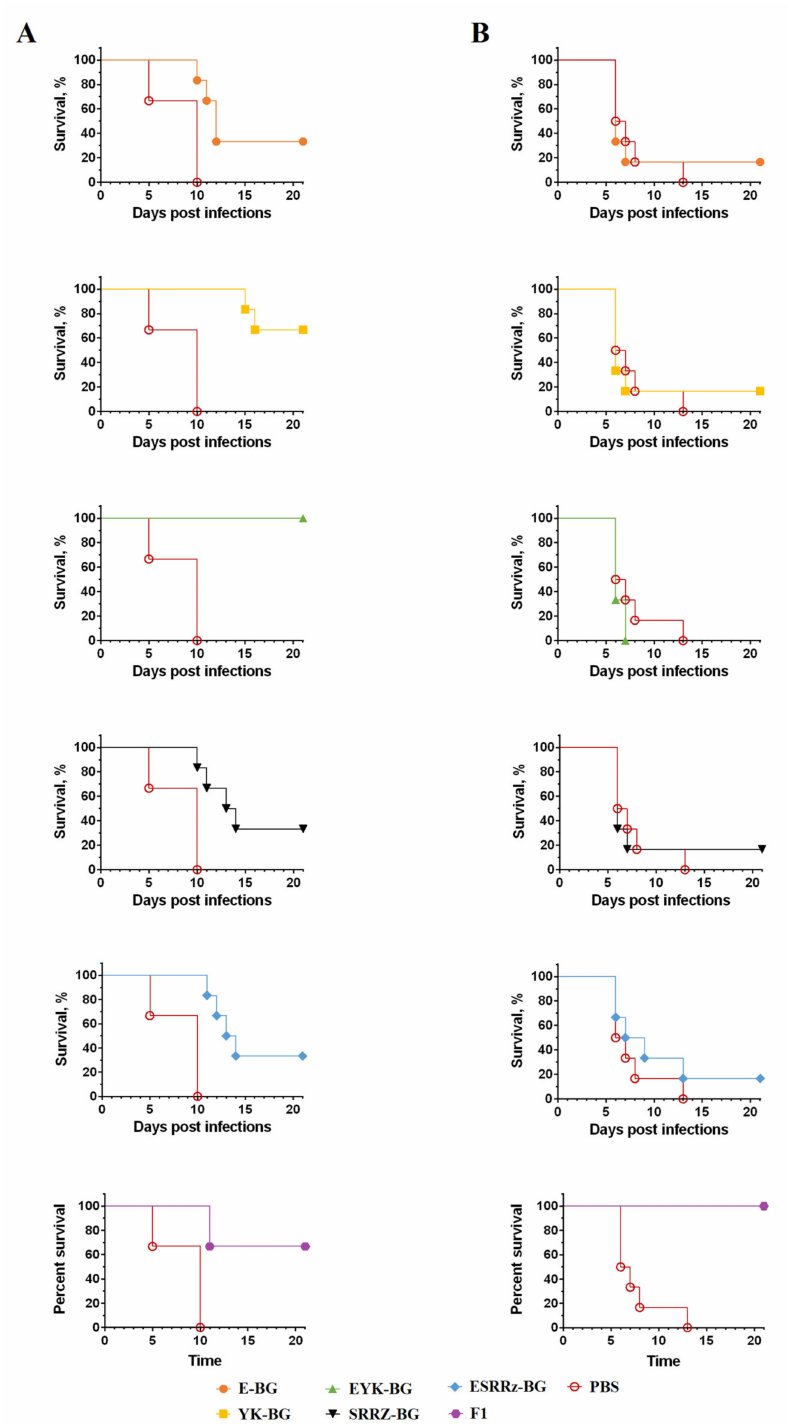
Figure 6. Protection of YP BGs against a lethal challenge with the wild-type Y. pestis 231 strain. Guinea pigs ( A ) and mice ( B ) were subjected to s.c. infection with different BGs strains or F1 at day 0 and boosted at day 14. 14 days after the last immunization, six mice and six guinea pigs from each group were challenged s.c. with 10 2 CFUs of wild-type Y. pestis 231 (33.3 LD 50 for mice and 14.3 LD 50 for